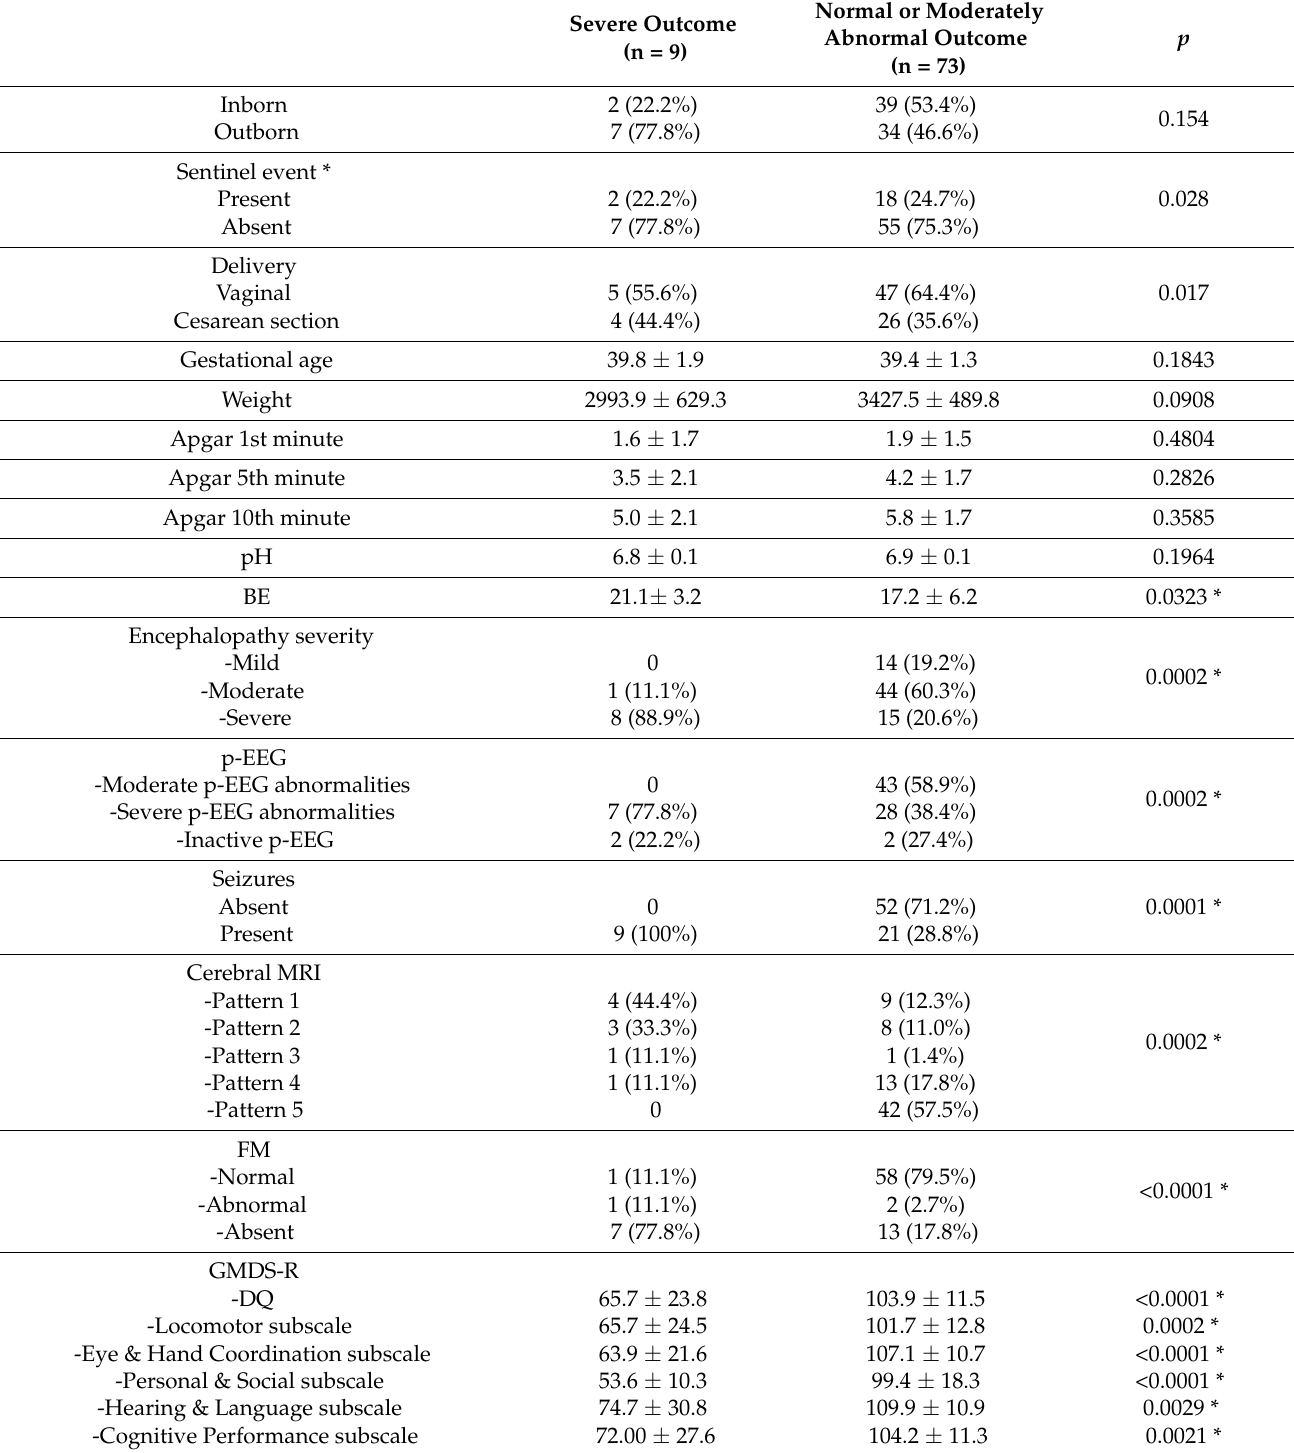
Table 2. Neuro-developmental outcome of infants with HIE who underwent TH. Normal or Moderately Severe Outcome Abnormal (n = 9)